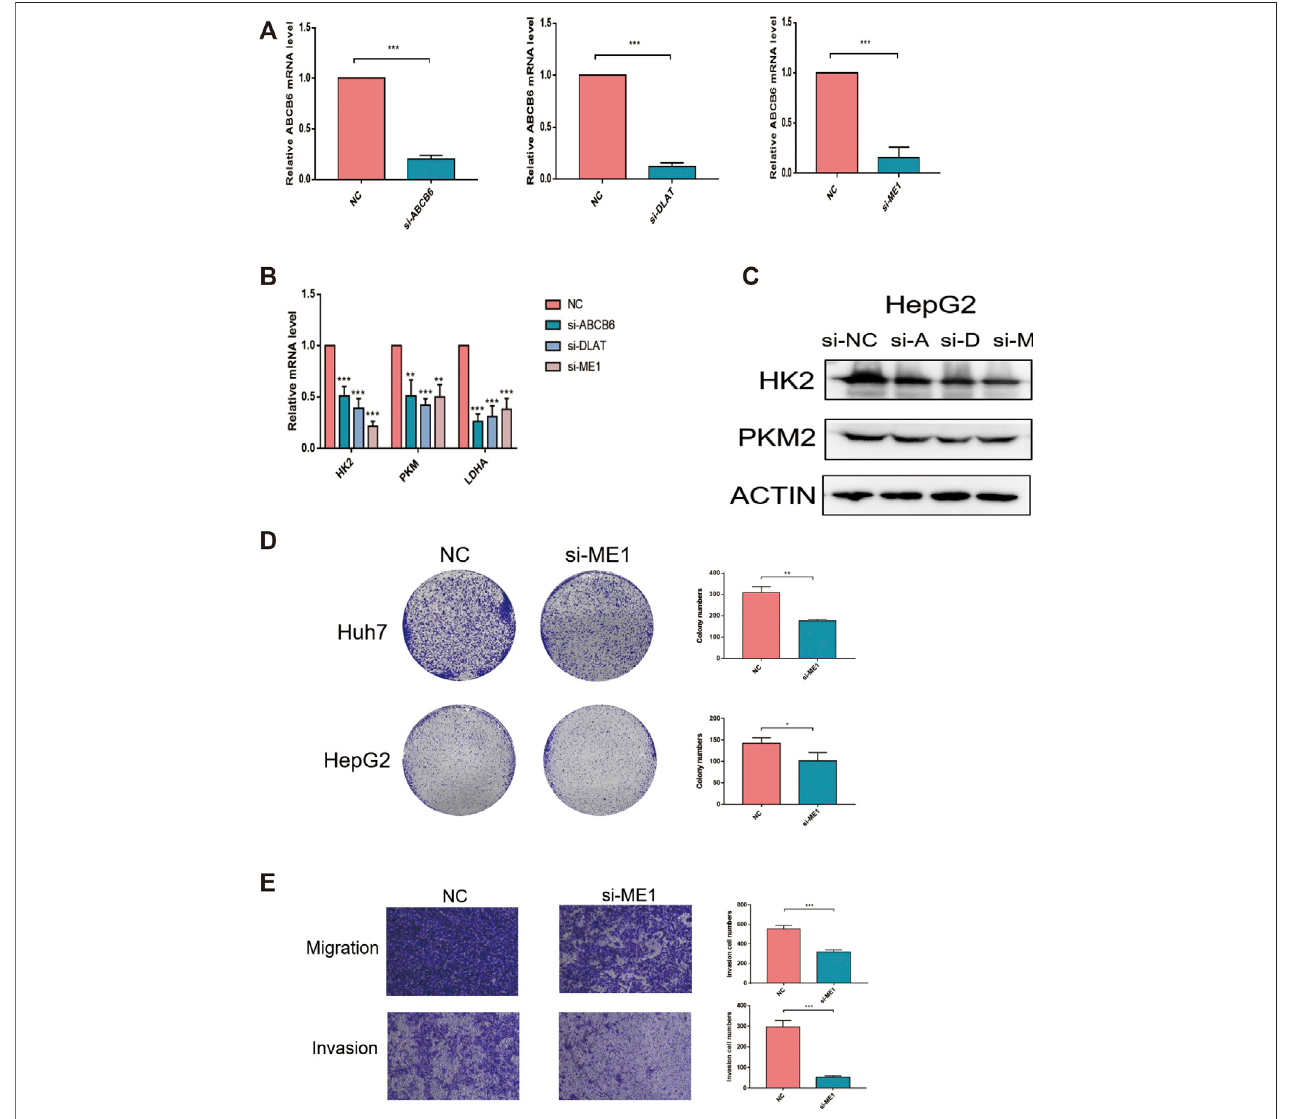
FIGURE 12 | Knockdown of ME1 suppressed the malignant phenotype of hepatocellular carcinoma cells. (A) Knockdown ef fi ciency of siRNA was assessed by qRT-PCR. (B) Relative mRNA expressions of HK2, PKM, and LDHA after knocking down ABCB6, DLAT, and ME1. (C) Protein expressions of HK2 and PKM2 after knockingdownABCB6,DLAT,andME1. (D) ReducedcolonynumbersinME1-silencedcellscomparedwithcontrolcells. (E) Differentmigrationandinvasioncapacities between ME1-silenced cells and control cells. * p < 0.05, ** p < 0.01, and *** p < 0.001. The data are presented as means ± SD of three independent experiments.